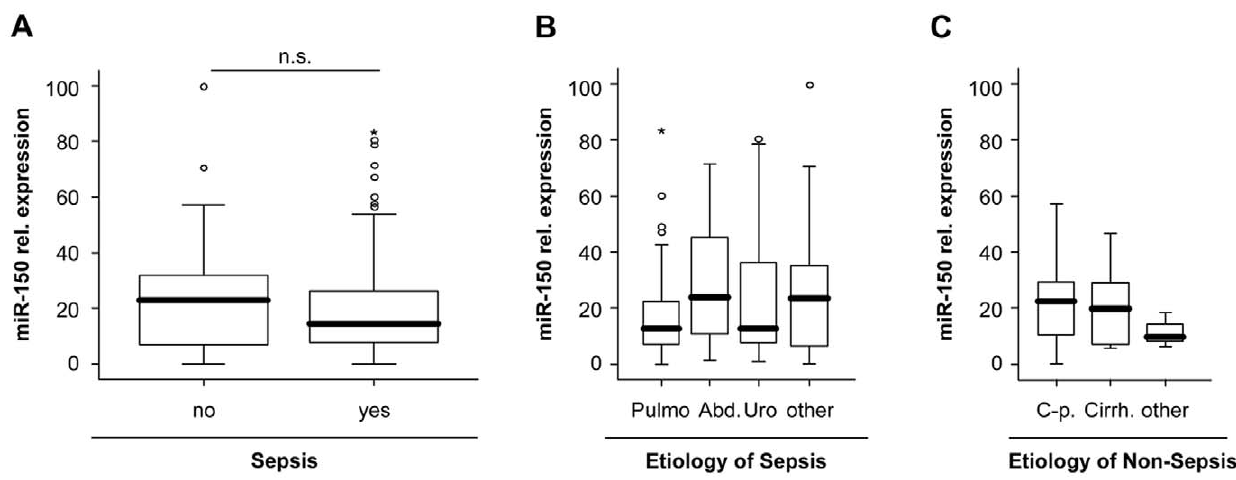
Figure 3. Serum miR-150 concentrations are unaltered in sepsis. (A) miR-150 serum levels were unchanged in patients that fulfilled sepsis criteria (n=157) compared to patients with non-septic etiology of critical illness. (B) miR-150 serum did not vary between the different sources of septic diseases (C) miR-150 serum did not vary between the different etiologies of non-septic diseases.